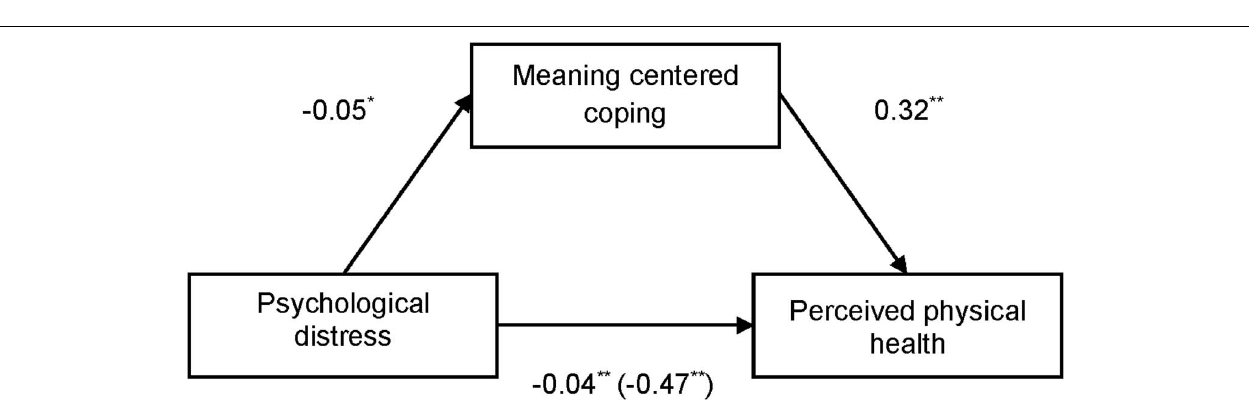
FIGURE 1 | Mediational analysis of subjective well-being in the relation between psychological distress and perceived physical health. Direct effect after including the mediator is in brackets. ** p ≤ 0.001; * p ≤ 0.05.